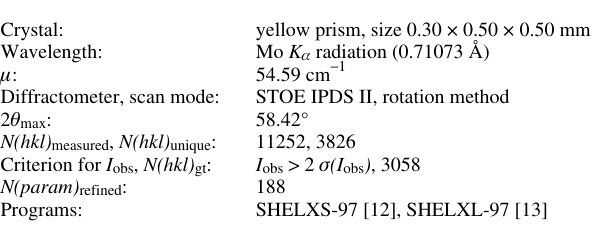
Table 1. Data collection and handling.